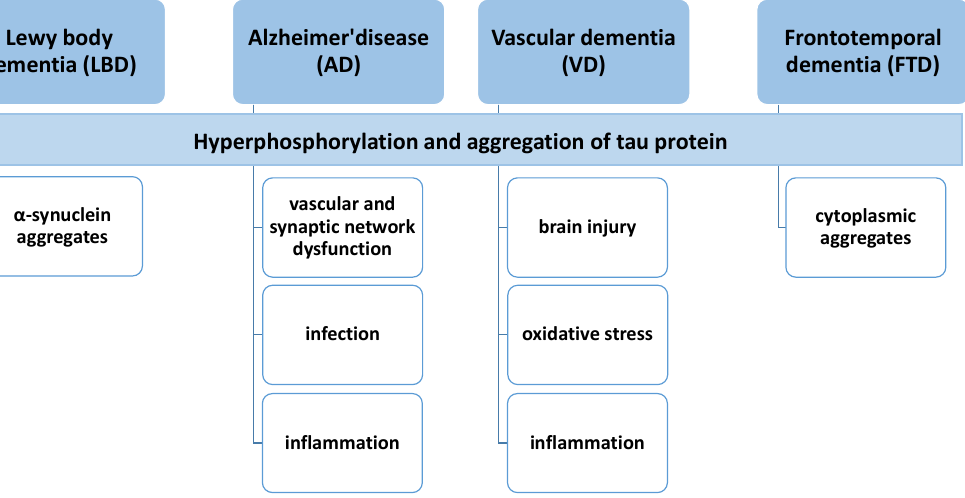
Figure 2. The similarities and differences between the types of dementia, based on their possible pathogenesis.